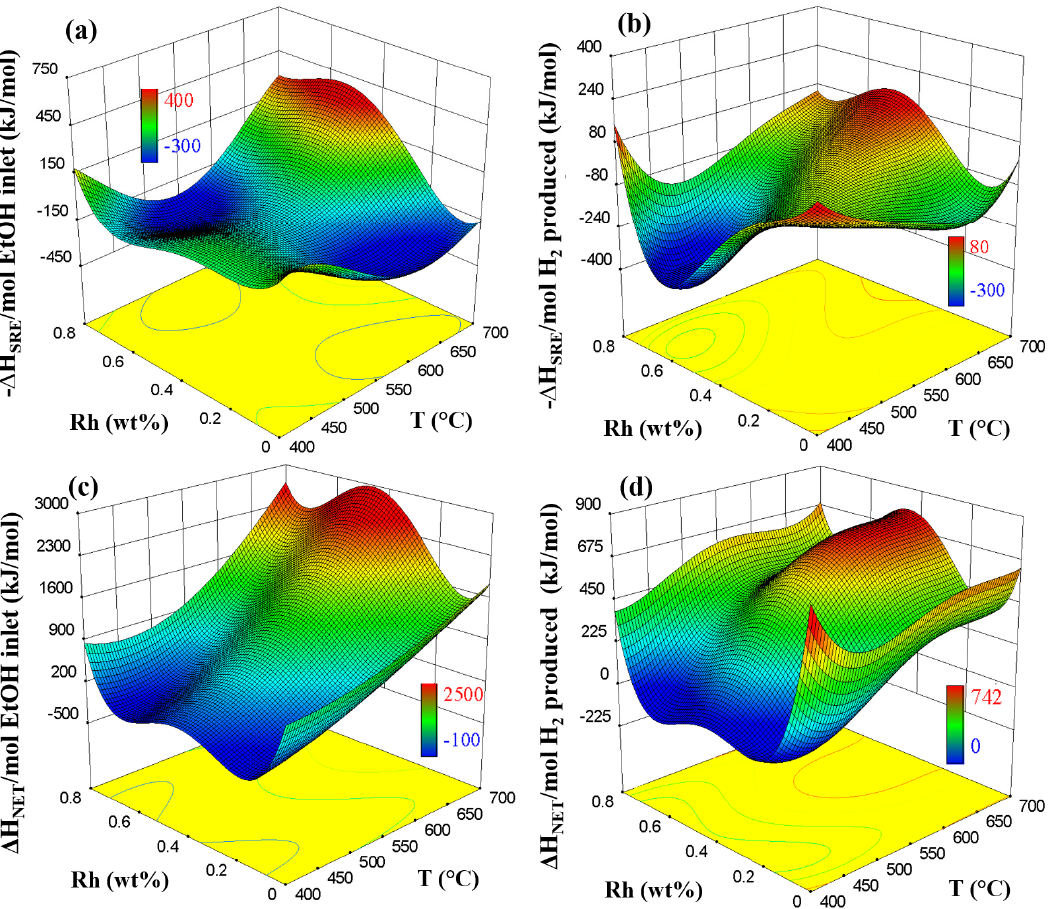
Figure 4. Changes in enthalpy during the SRE and net energy production of the system computed with Aspen Plus in terms of ethanol ‐ inlet (( a ) and ( c )) and H 2 (( b ) and ( d )) produced. Total metal loading (Rh + Pt) = 0.8 wt % in all Rh–Pt/CeO 2 catalysts. Response surface: Quartic model, R 2 > 0.85; Adjusted, R 2 > 0.8, Probability F << 0.1 (significant) and Lack of Fit >> 3 (nonsignificant).